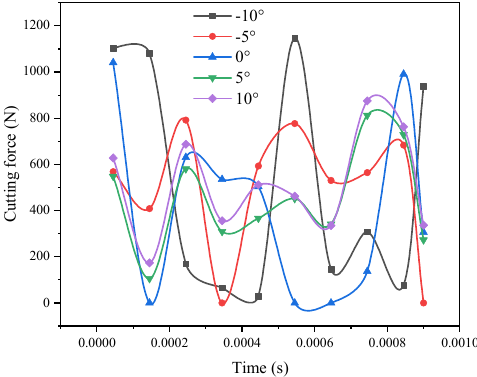
Figure 1. Comparison curve of the cutting force under different tool rake angles.